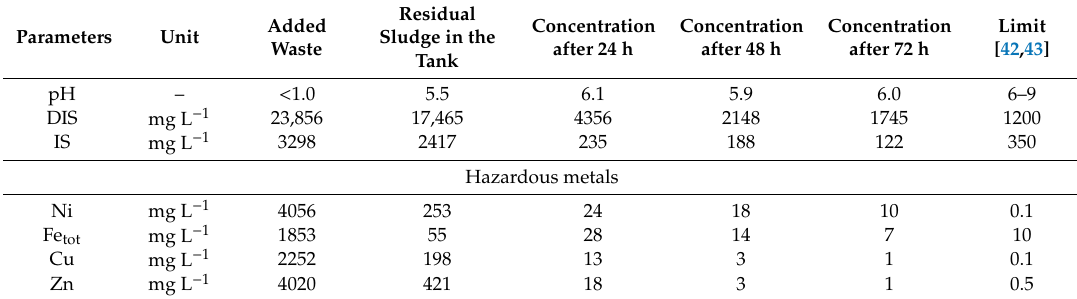
Table 5. Results of the analysis depending on the duration of action of the biosorbent used.